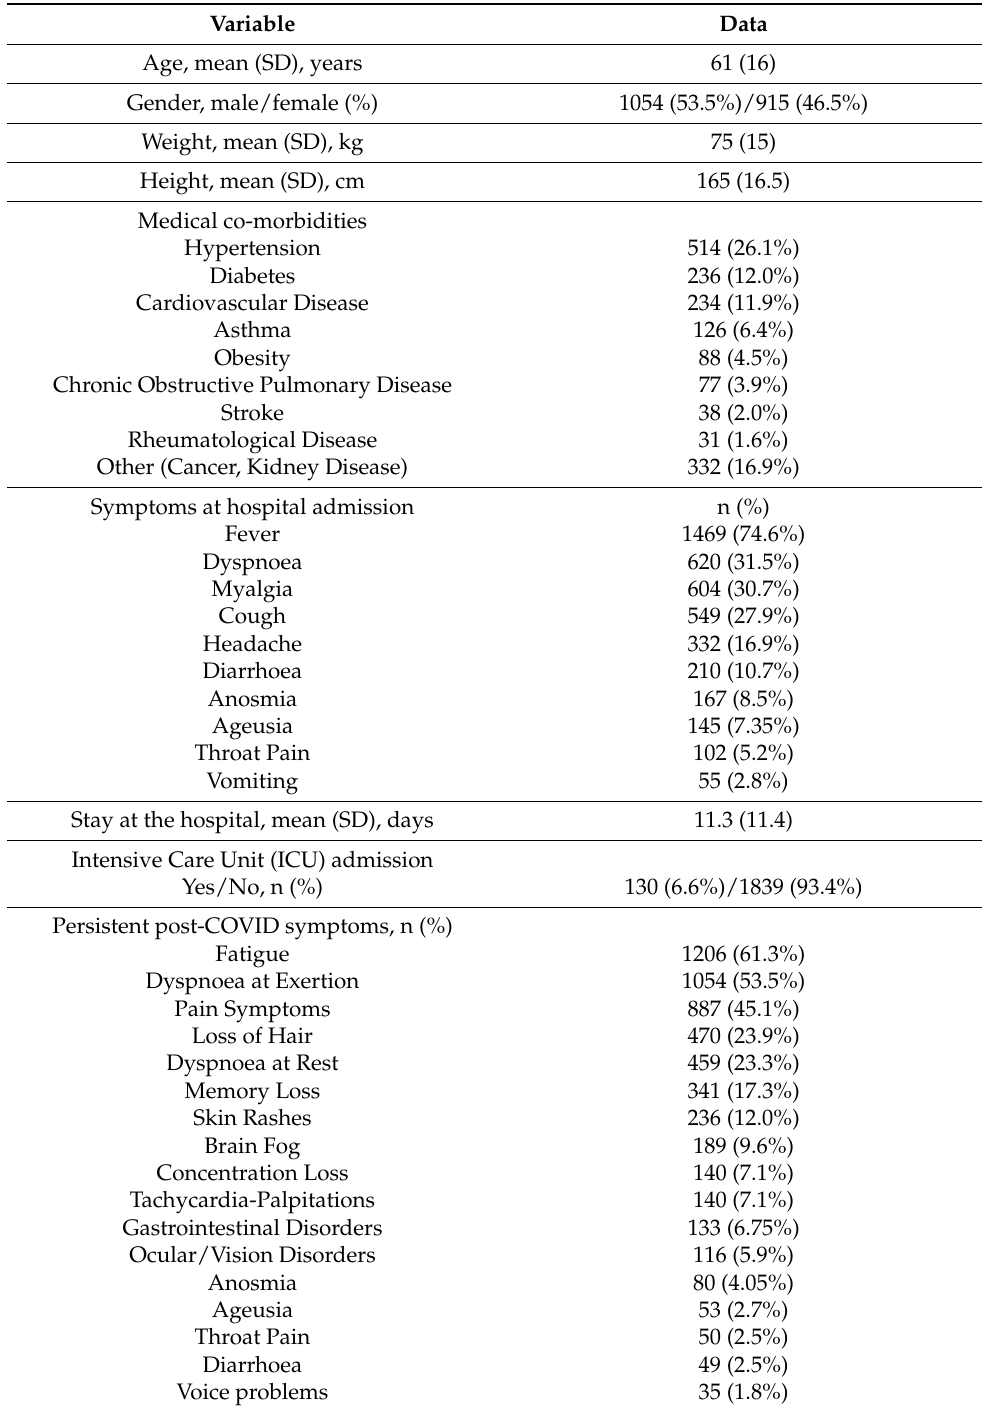
Table 1. Clinical/Hospitalization Data and Post-COVID Symptoms (n =